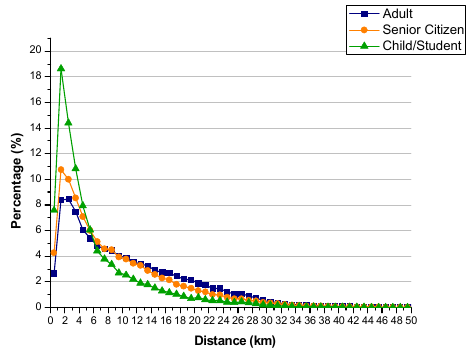
Figure 4. Probability density function of distance for the